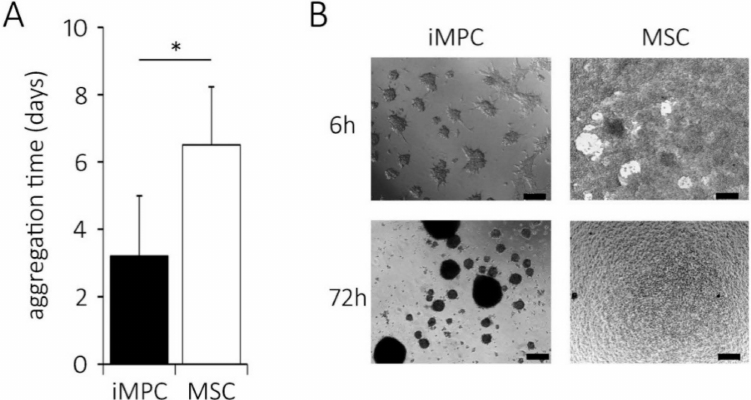
Figure 5. The condensation assay for iMPCs and MSCs. The 5 × 10 5 cells were seeded onto the uncoated tissue culture plastic in a chondrogenic medium supplemented with 10 ng / mL of TGF β . ( A ) The completion of aggregate formation was judged visually in standardized time intervals. ( n = 5 independent iMPC populations [black bar] and n = 4 independent MSC donor populations [white bar]; mean ± standard deviation; * p < 0.05 between groups, Mann-Whitney U-test). ( B ) The aggregate morphology at 6 h and 72 h after seeding (scale bar = 200 µ